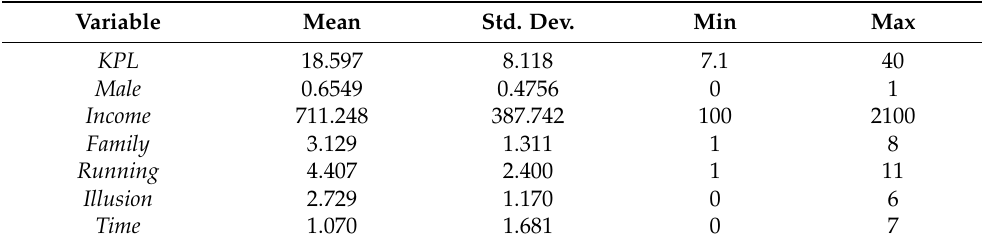
Table 3. Summary statistics of each variable.